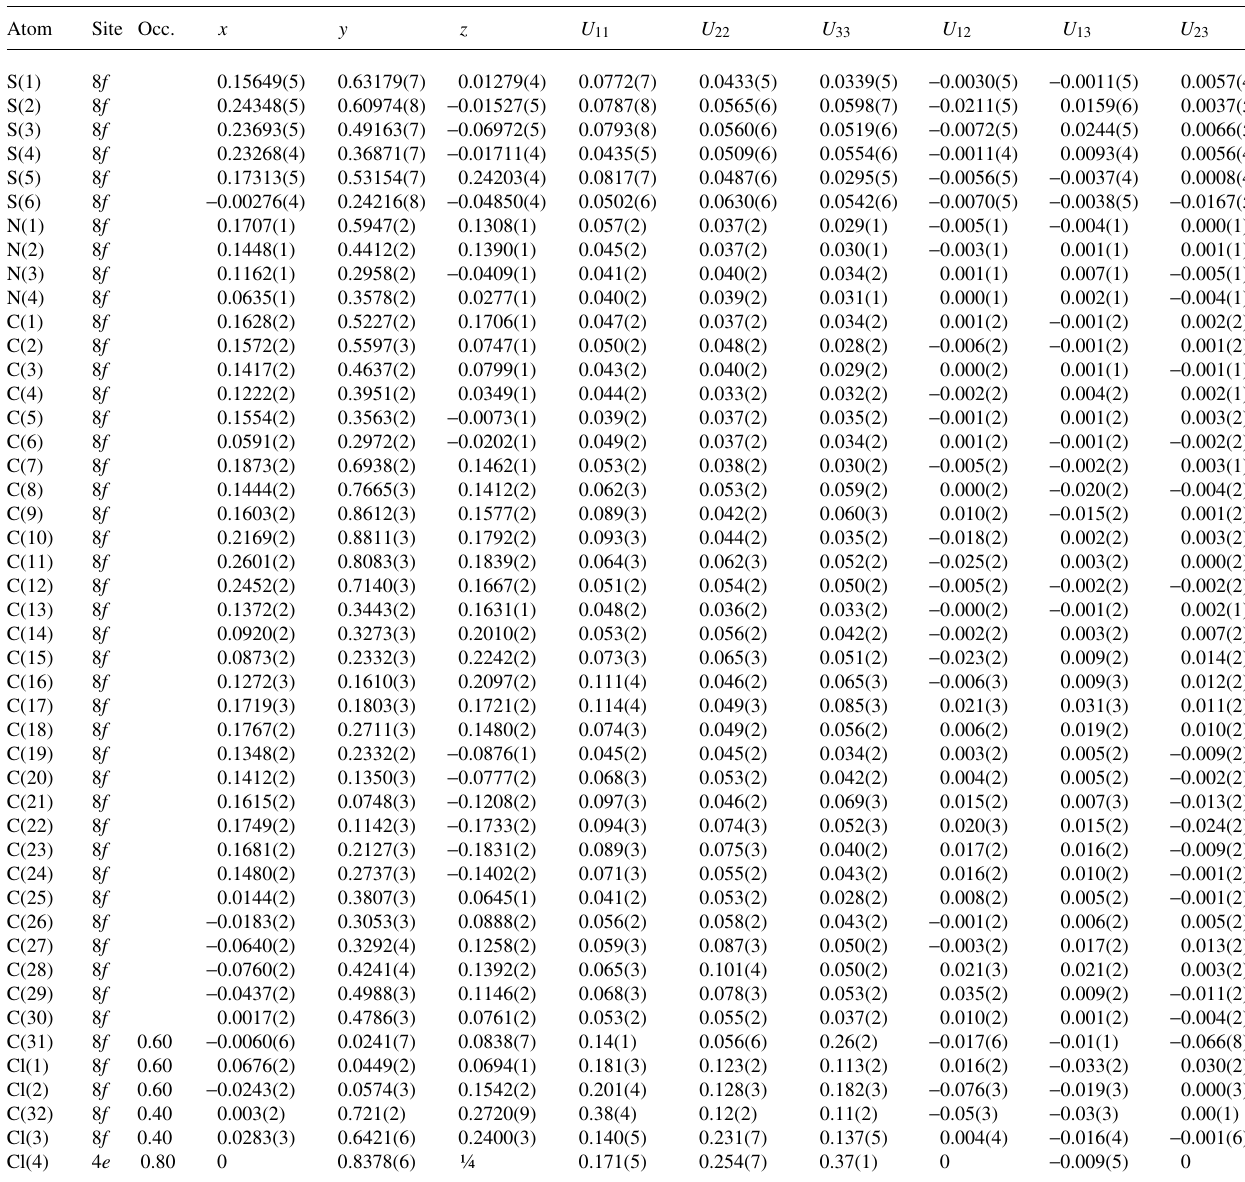
Table 3. Atomic coordinates and displacement parameters (in Å 2 )